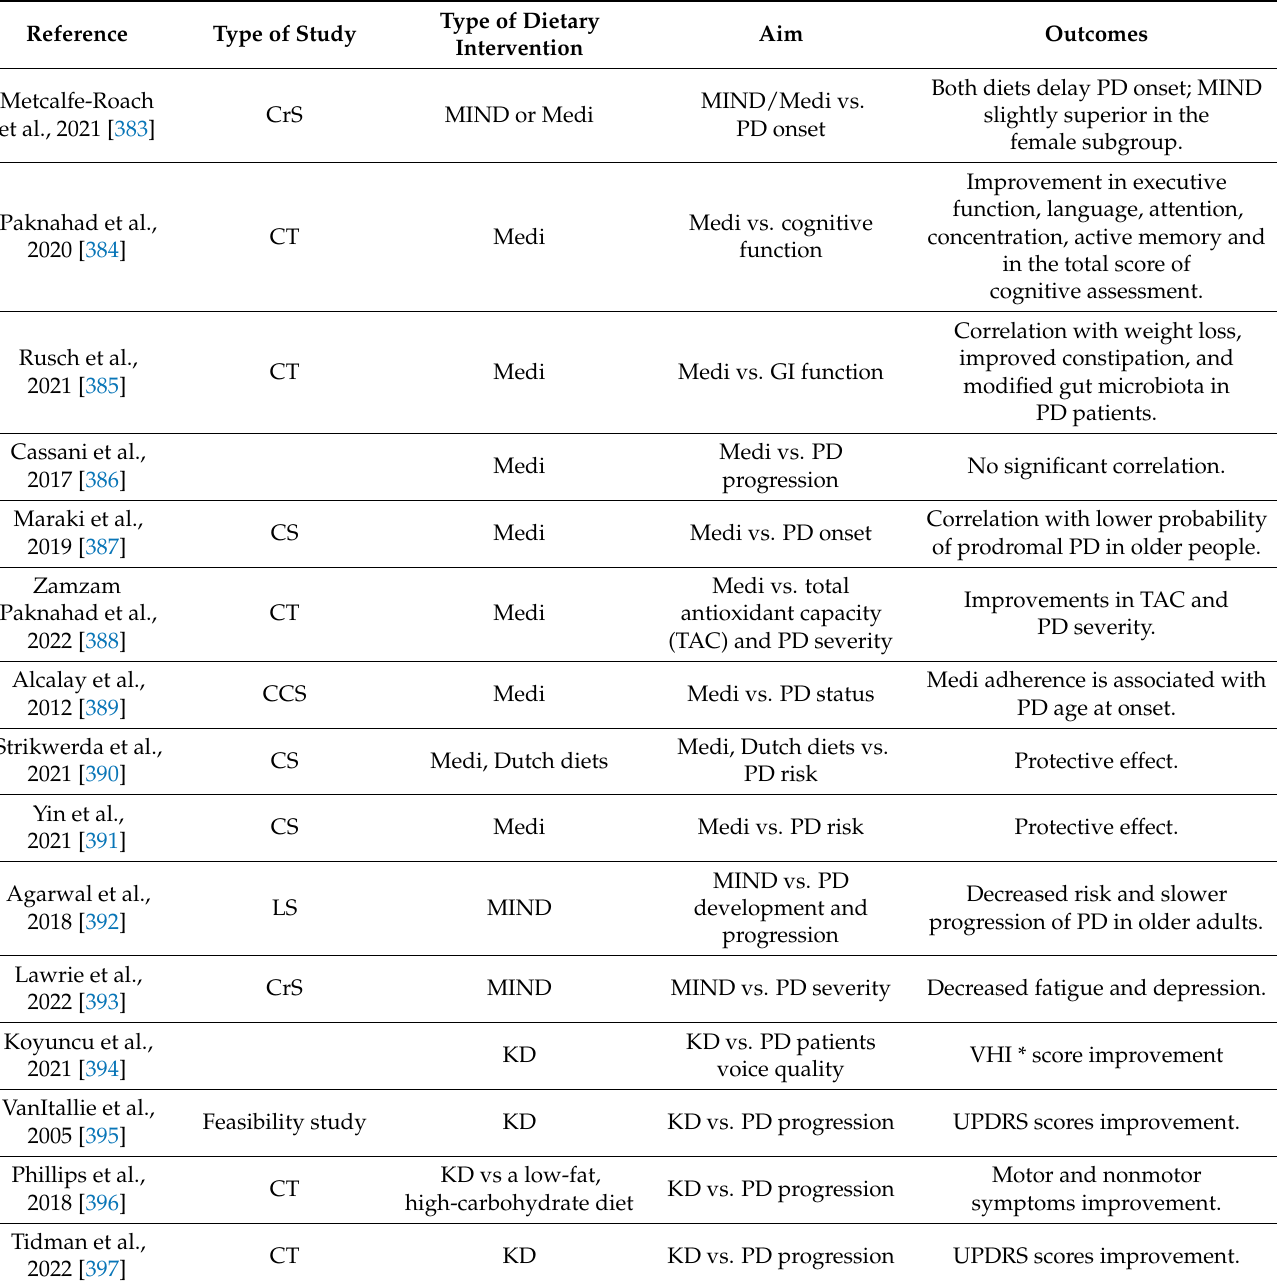
Table 3. The effects of dietary interventions in PD clinical